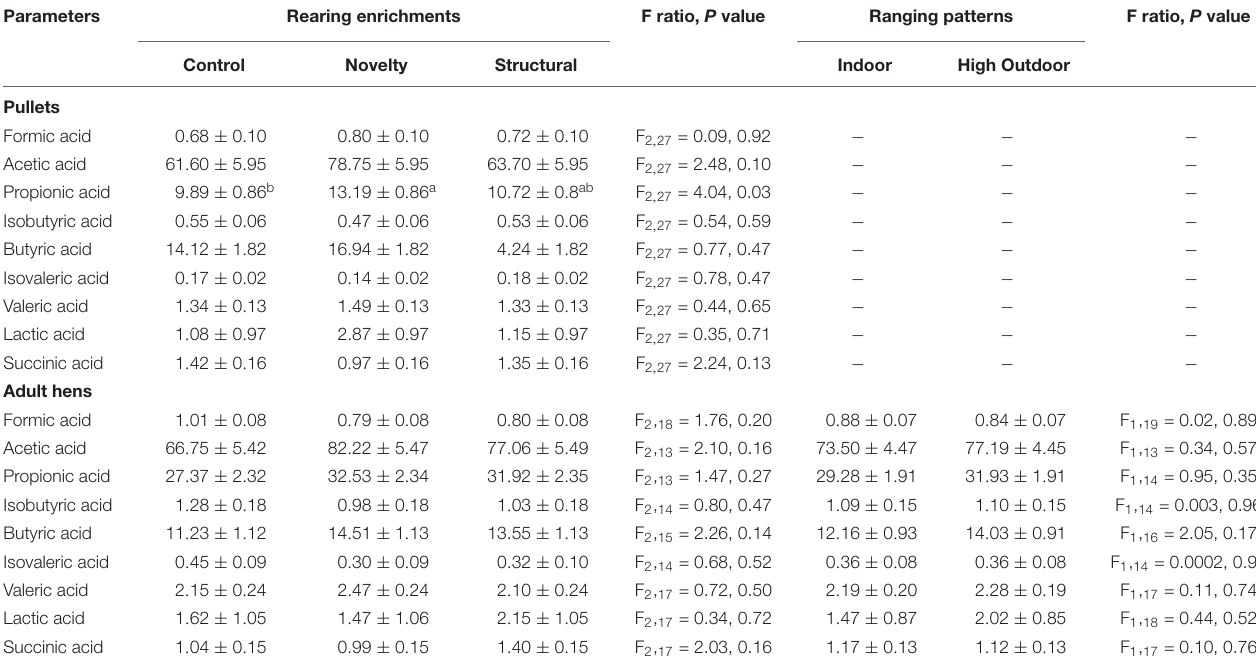
TABLE 1 | Least squares means (LSM) ± SEM of short-chain fatty acids (SCFAs) ( µ mol/g) in cecal contents of pullets and adult free-range hens from different rearing enrichment treatments (control, novelty, structural) and ranging patterns (indoor, high outdoor). Parameters Rearing enrichments F ratio, P value Ranging patterns F ratio, P value Control Novelty Structural Indoor High